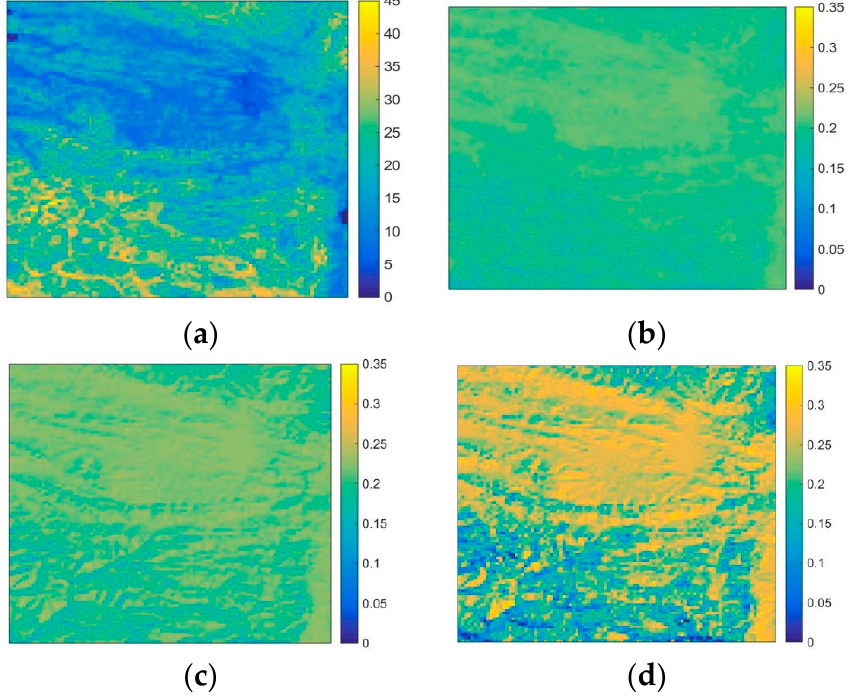
Figure 9. Maps of mean slope ( a ) within each 1-km pixel and the spatial distributions of BSA with different SZAs: ( b ) 0°; ( c ) 30°; and ( d ) 60°.